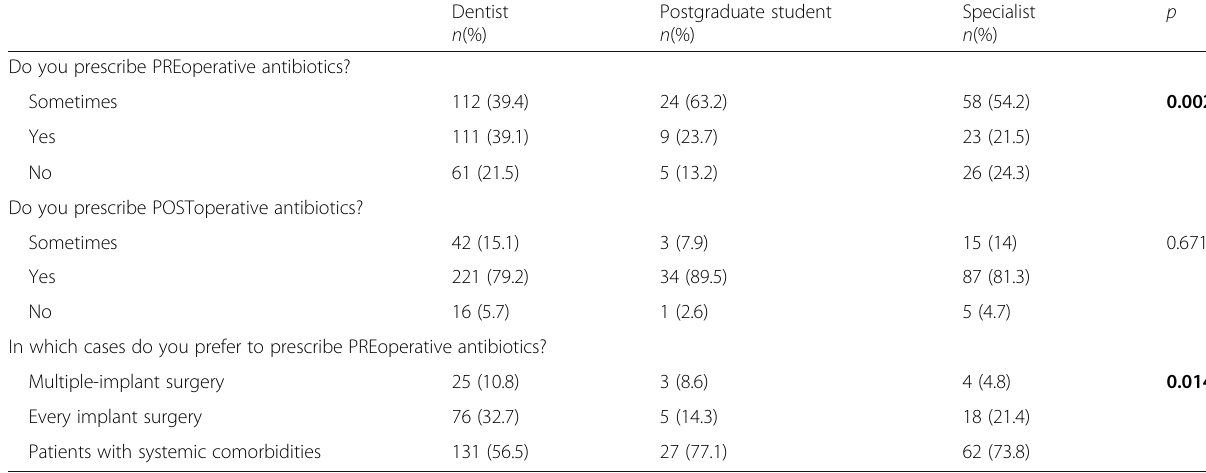
Table 7 The relationship between antibiotic prescribing habits and the titles of the clinicians.